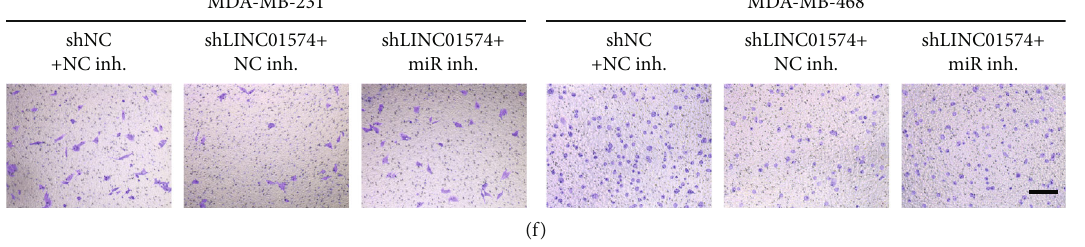
Figure 6: LINC01574 regulated BC cell proliferation, migration, and invasion by targeting miR-6745. (a, b) After corresponding transfection, the OD value and cloning numbers of BC cells were evaluated. (c, e) After corresponding transfection, the wound closure rates of BC cells were tested. (d, f) After corresponding transfection, the number of invasive BC cells was tested. ∗ P < 0 : 05 , ∗∗ P < 0 : 01 , and ∗∗∗ P < 0 : 001